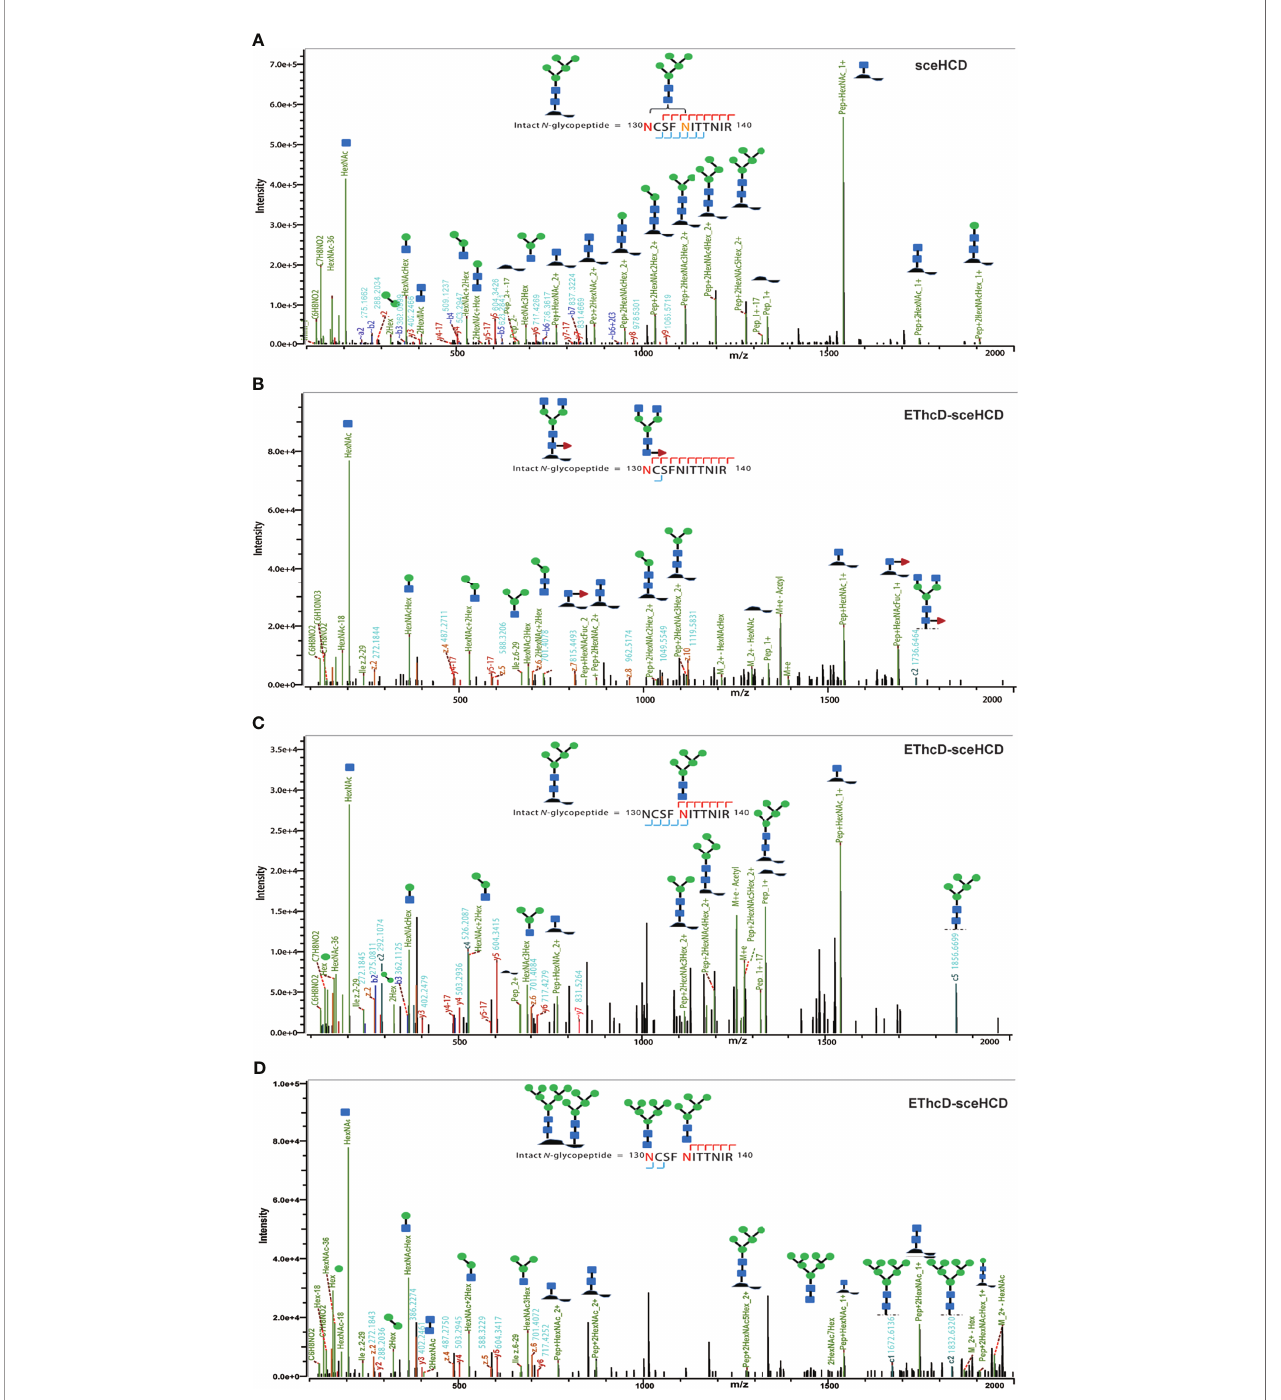
FIGURE 3 | Representative sceHCD-MS/MS (A) and EThcd-sceHCD-MS/MS (B – D) spectra of intact N-glycopeptides with two potential N-glycosites (N130 and